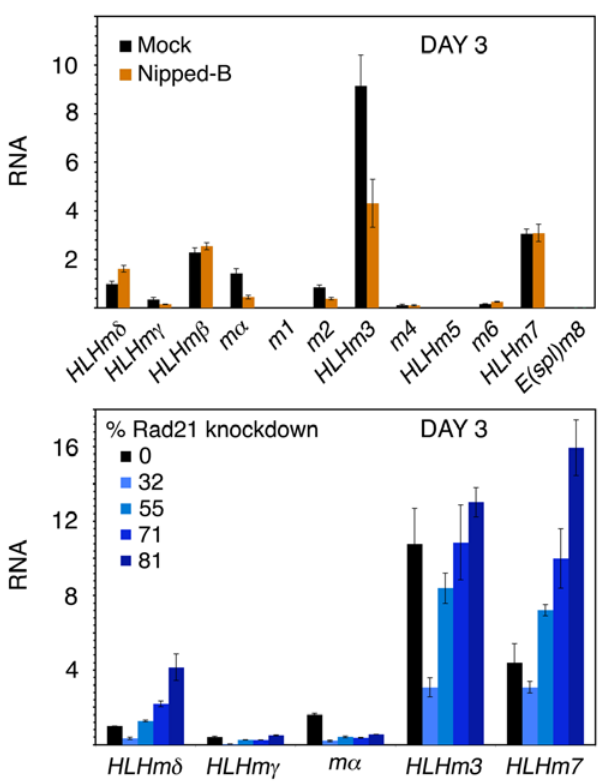
Figure 3. Biphasic changes in E(spl)-C transcripts after Nipped- B and Rad21 knockdown in BG3 cells. The top panel shows E(spl)-C transcript levels in mock-treated (black) or Nipped-B RNAi treated (orange) BG3 cells three days after treatment. Similar results were obtained in all Nipped-B RNAi experiments. All levels are relative to HLHm d in mock-treated cells. The data shown is an average of two RNAi experiments. The bottom panel shows the indicated E(spl)-C transcript levels three days after treatments with increasing amounts of Rad21 dsRNA that cause different extents of knockdown (mock, 0%; 0.7 m g per 3 cm well, 32%; 1.7 m g, 55%; 3.3 m g, 71%; 6.7 m g, 81%).